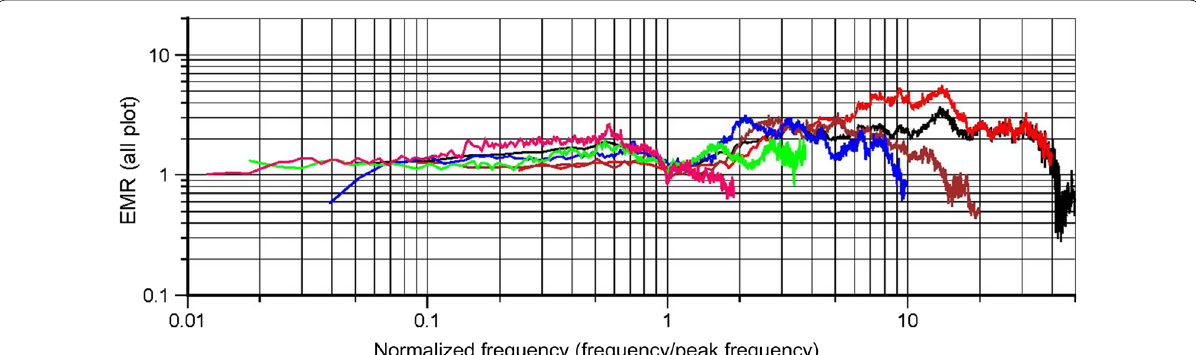
Fig. 12 Comparison of the average EMRs for five categories with the EMR for the whole frequency without categorization (Fig. 10). Peak frequency exists in (red) 0.1–1.0 Hz, (brown) 1.02–2.0 Hz, (blue) 2.02–5.0 Hz, (green) 5.02–10.0 Hz, (pink) 10.02–20.0 Hz, and (black) all